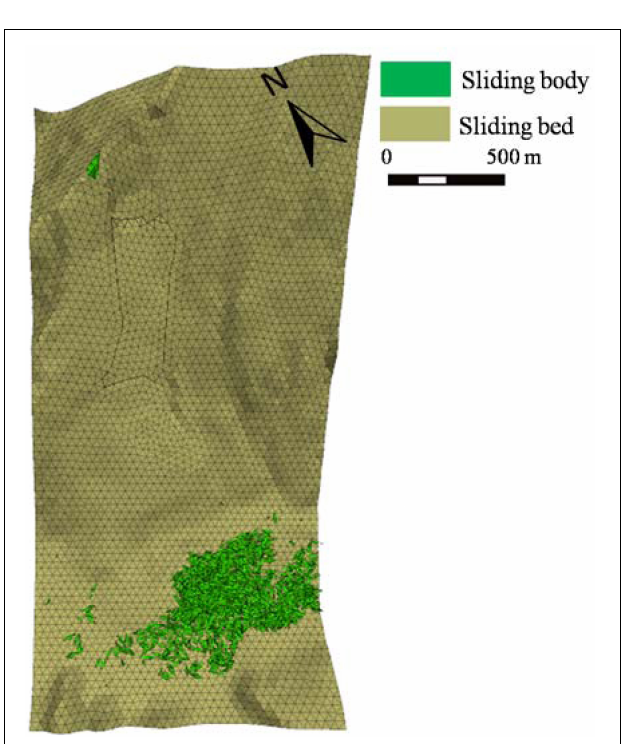
FIGURE 16 | Simulated deposit of the Xinmo Landslide in rigid bed condition. Part of the blocks sliding out of the model range is not